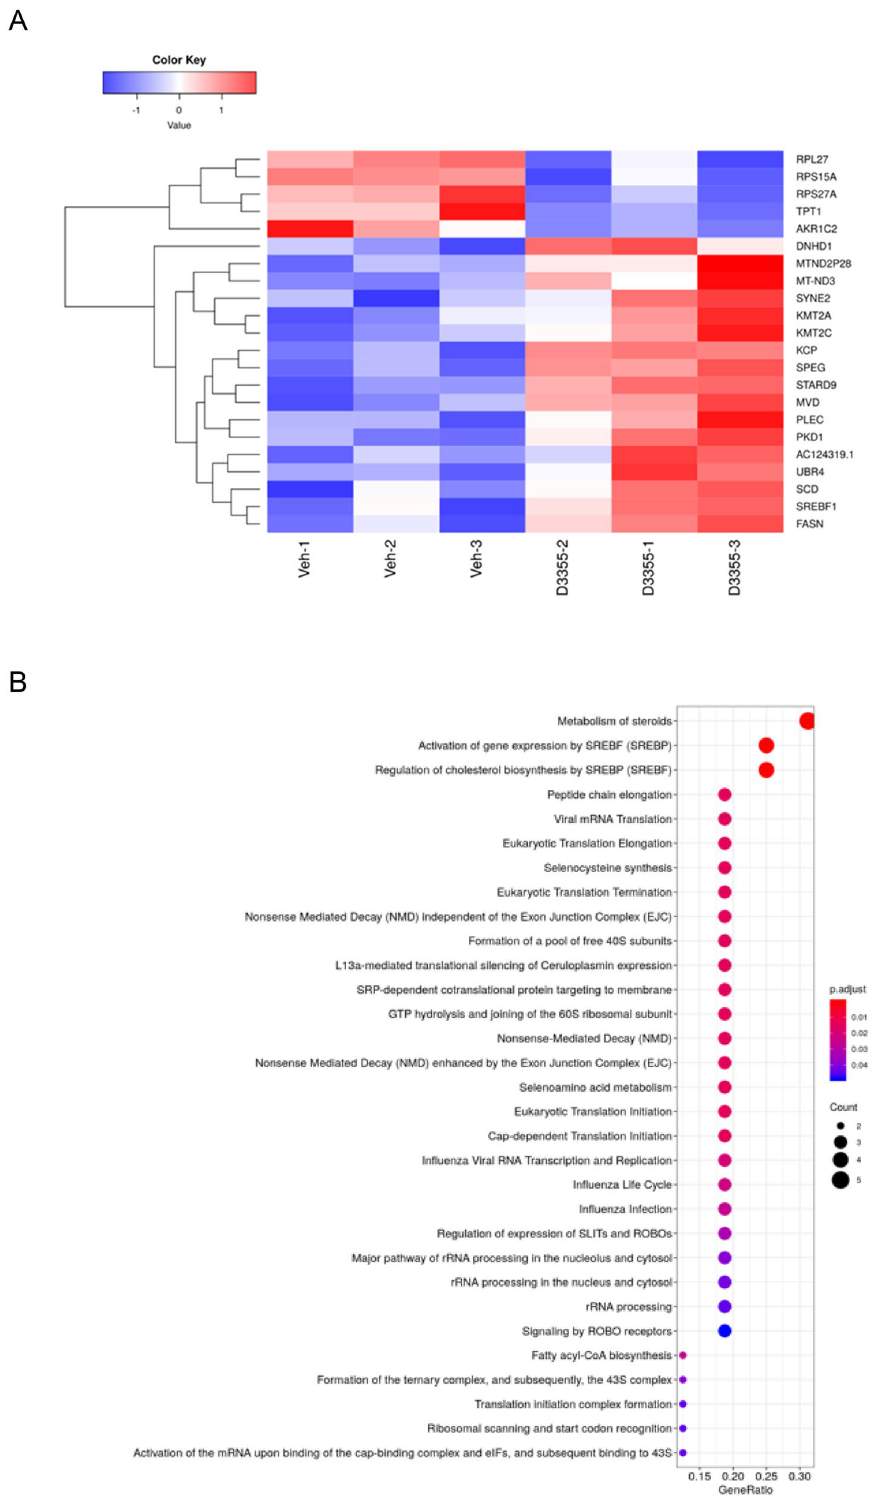
Figure 3. Differential gene expression and molecular pathway analysis in primary human hepatic stellate cells treated with AZD3355. Primary human hepatic stellate cells were treated with either DMSO (as vehicle) or AZD3355 (30 nM) for 72 h. A heatmap was generated from RNA-seq data ( A ) summarizing -significantly differentially expressed genes (padj < 0.1) in AZD3355 treated cells compared to vehicle control. Enrichment analysis of differentially expressed genes ( B ) reveals the top pathway identified: ‘Metabolism of steroids’, which contains the genes AKR1C2, SCD, MVD, SREBF1 and